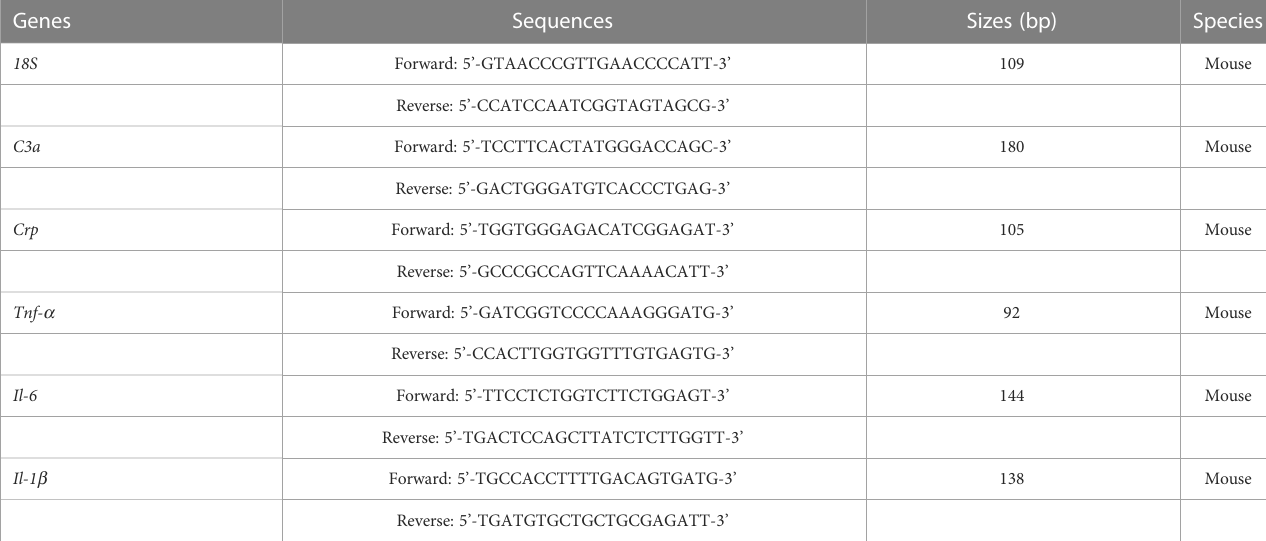
TABLE 1 Oligonucleotide sequences and size of primers.